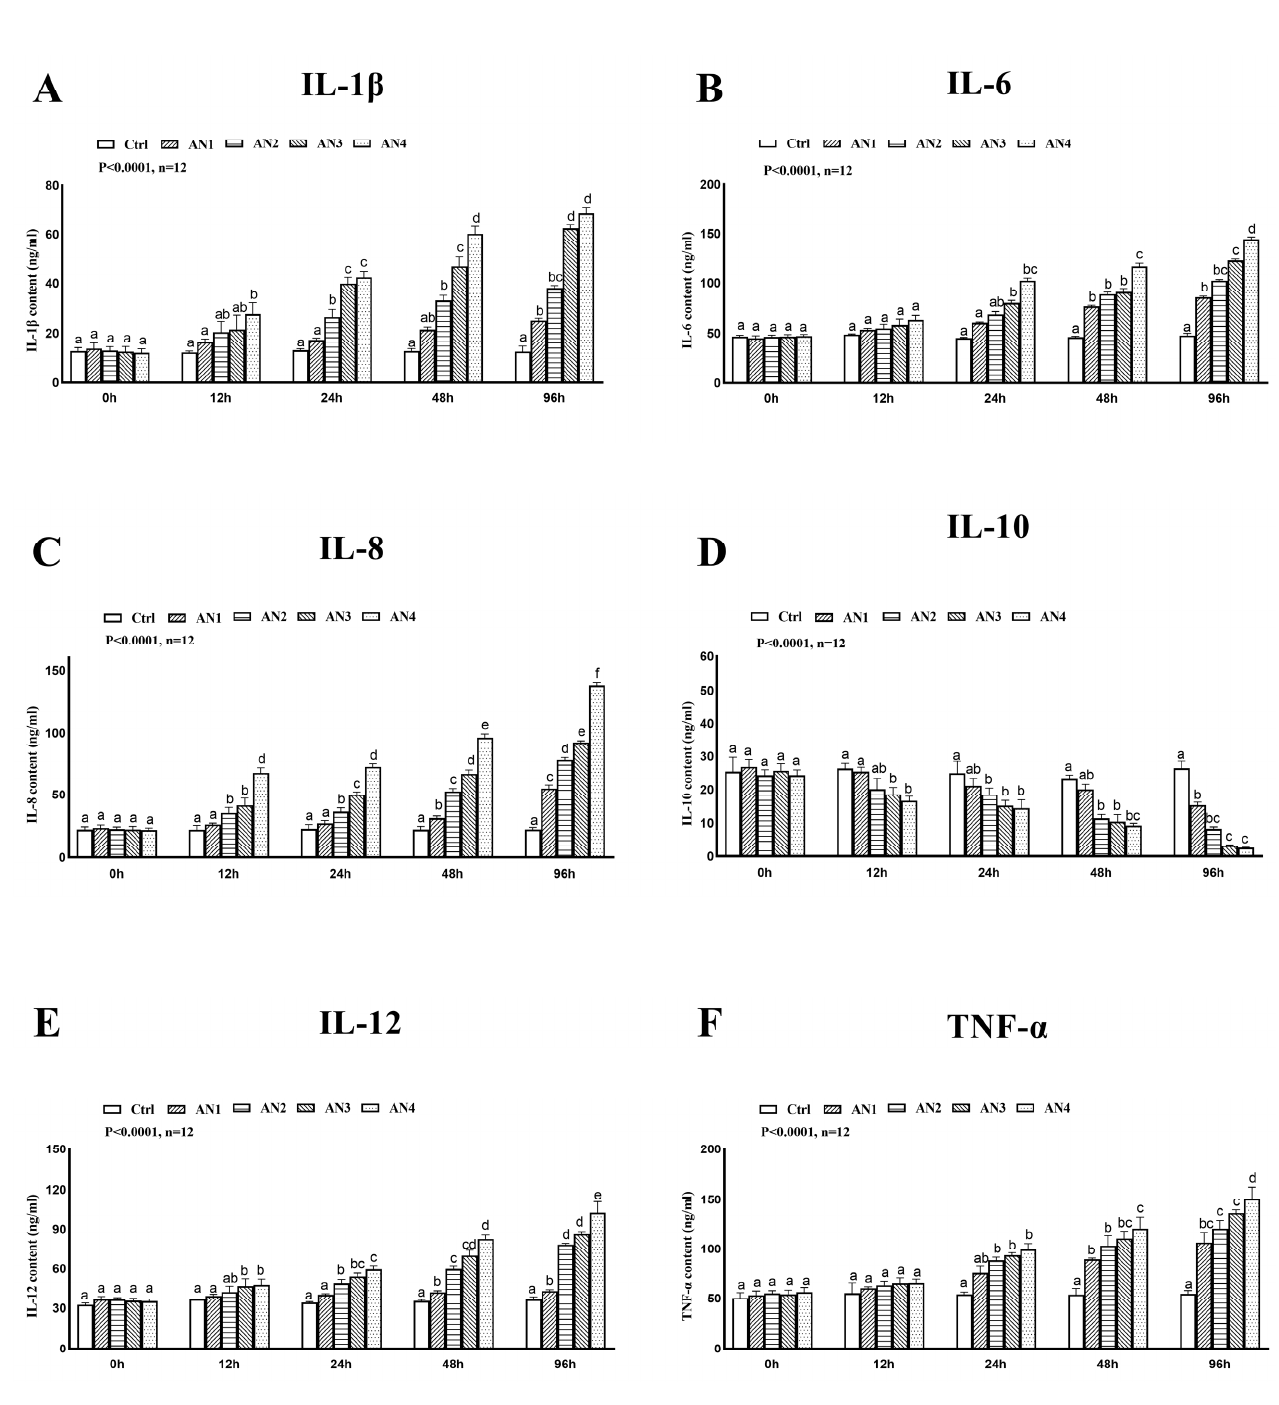
Figure 8. Changes of cytokine activity of bighead carp exposed to ammonia. ( A ) Interleukin-1 β (IL-1 β ), ( B ) Interleukin-6 (IL-6), ( C ) Interleukin-8 (IL-8), ( D ) Interleukin-10 (IL-10), ( E ) Interleukin-12 (IL-12), ( F ) Tumor necrosis factor- α (TNF- α ). Values are expressed as mean ± standard error (SE) from triplicate groups (n = 12). Bars with different letters (a, b, c, d, e, f) differ significantly from those of other groups ( p < 0.05).